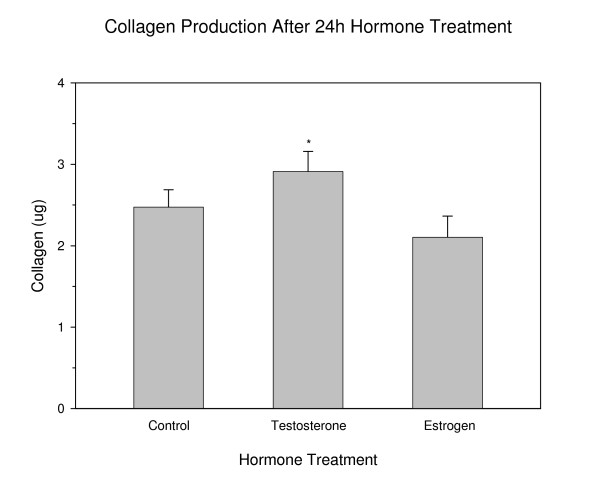
Collagen Type I (μg) measured by ELISA in LAD fibroblasts treated with 10-7M testosterone or 10-7M estrogen. Testosterone significantly increased the amount of collagen deposited (2.912 ± 0.247 μg) compared to control values (2.475 ± 0.211 μg) (* p < 0.05, 1 tailed t-test). Estrogen decreased the amount of collagen (2.103 ± 0.262 μg) compared to control (p = 0.058, 1 tailed t-test). Collagen was measured in wells with a 0.32 cm2 growth area from a 96 well culture plate.